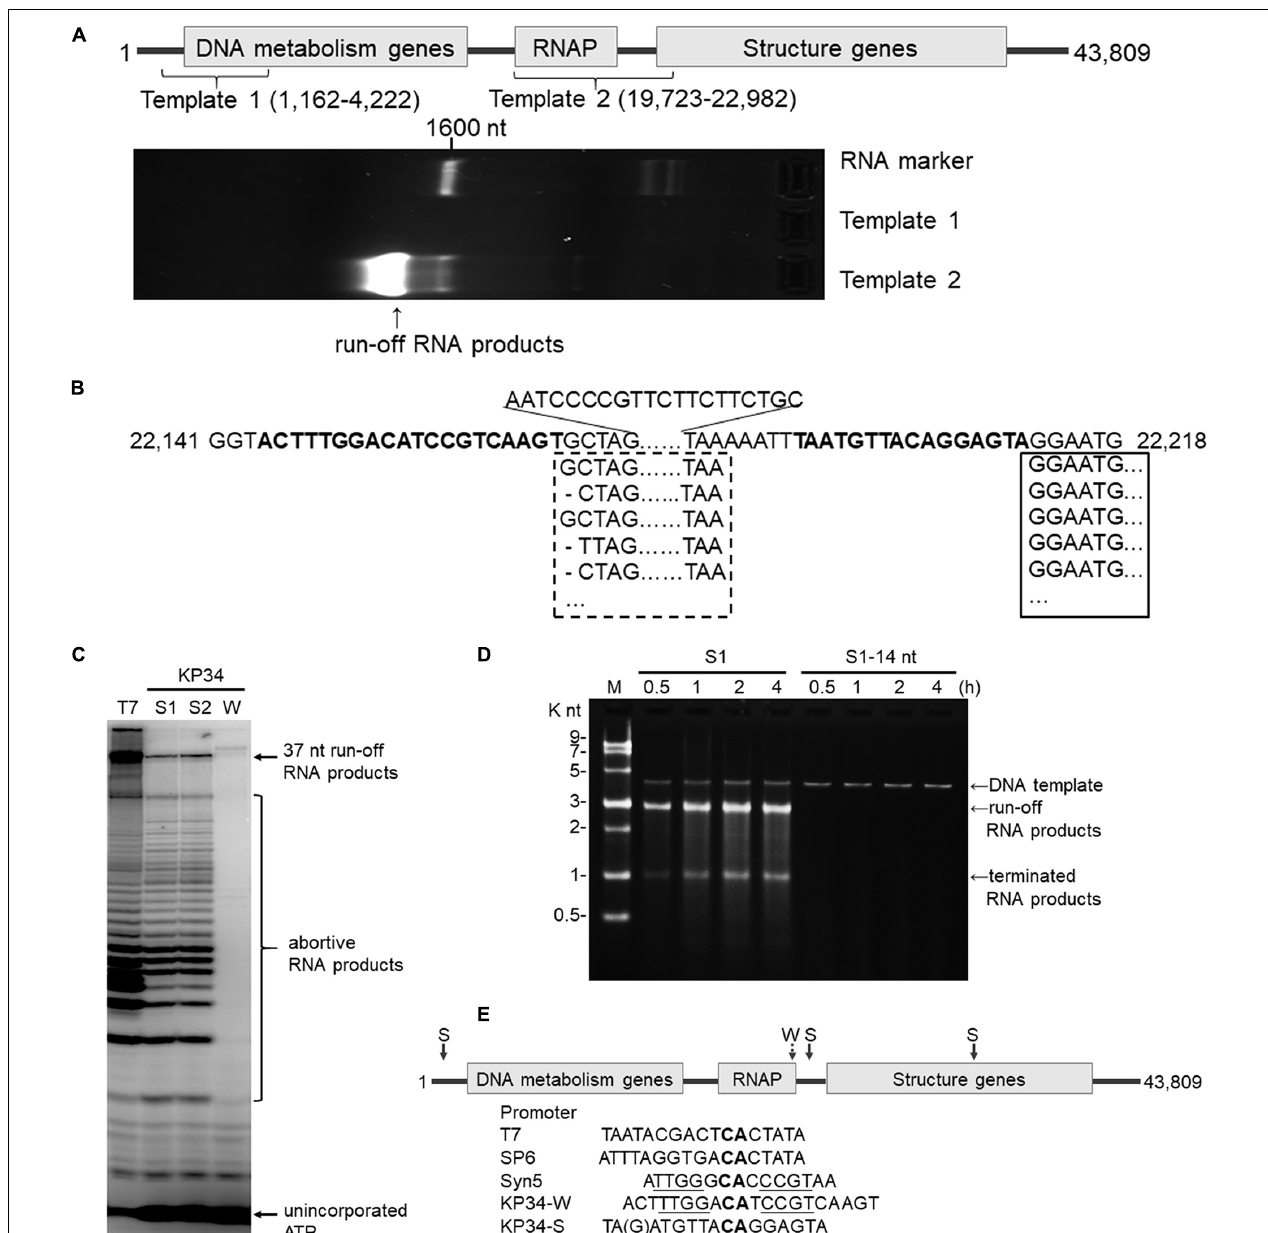
FIGURE 2 | Identification of the KP34 RNAP promoter. (A) The DNA fragment (Template 1) containing previously predicated promoters failed to serve as transcription template for KP34 RNAP to produce RNA in vitro , while the DNA fragment covering the RNAP gene and downstream gap region (Template 2) was active as transcription template. RNA products are shown as bright bands on the 2% TAE agarose gel. (B) 5 (cid:48) -RACE analysis of the position of transcription initiation. 5 (cid:48) sequence of KP34 transcripts were matched to KP34 genome. Major sequences were in solid box and minor sequences in dotted box. Their upstream region containing putative promoters is shown in bold. (C) Comparison of run-off RNA synthesis by T7 and KP34 RNAP under the control of various promoters. A DNA template containing a T7 promoter (5 (cid:48) -TAATACGACTCACTATA-3 (cid:48) ) was incubated with 100 nM T7 RNAP, and three DNA templates containing either a KP34 strong promoter S1 (5 (cid:48) -TAATGTTACAGGAGTA-3 (cid:48) ), a KP34 strong promoter S2 (5 (cid:48) -TGATGTTACAGGAGTA-3 (cid:48) ), or a KP34 weak promoter W (5 (cid:48) -ACTTTGGACATCCG TCAAGT-3 (cid:48) ) were incubated with 100 nM KP34 RNAP to direct to the transcription of their downstream sequence that encodes the same 37 nt RNA. [ α -32P]ATP was added into reactions for imaging and visualization. Reaction products were separated by a 25% TBE-Urea denaturing gel. (D) Identification of the full KP34 strong promoter. A KP34 strong promoter S1 (5 (cid:48) -TAATGTTACAGGAGTA-3 (cid:48) ) or the 3 (cid:48) 14 nt common sequence of the two KP34 strong promoters (5 (cid:48) -ATGTTA CAGGAGTA-3 (cid:48) ) was inserted into plasmid pUC19 to direct the transcription of their downstream sequences, respectively. A run-off transcript of ∼ 2700 nt and a terminated transcript of ∼ 1000 nt (terminated by a predictable T7 class I hairpin terminator structure) were expected from the linearized form of these plasmids if the inserted promoter is sufficient to direct transcription by KP34 RNAP. M: ssRNA Ladder. (E) KP34 promoters in the genome (location of strong promoter (S) pointed by solid arrow and weak promoter (W) by dotted arrow) and comparison of typical ssRNAP promoters. Conserved sequence among ssRNAP promoters are in bold and those homologous between Syn5 promoter and KP34 weak promoter are